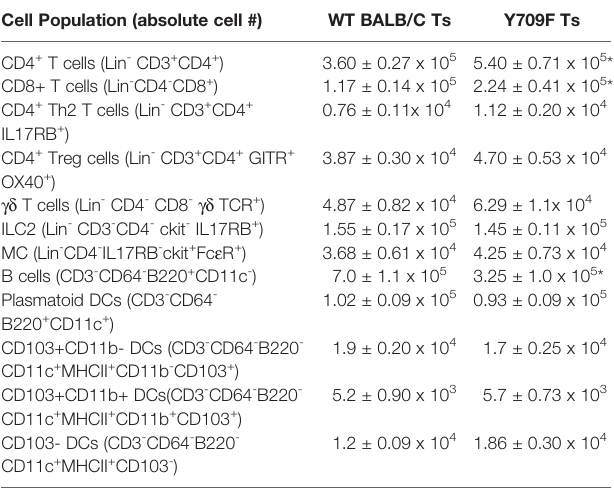
*denotes statistical signi fi cance. Lin, lineage; MC, mast cells; DC, dendritic